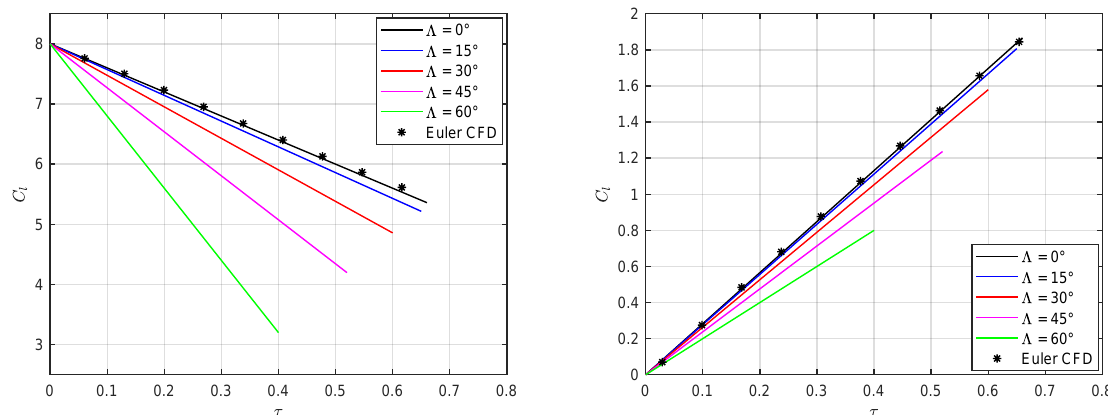
Figure 7. The sweep effect on the incipient indicial lift for thin aerofoil in compressible flow: AOA ( left ) and SEG ( right ), with M ∞ =